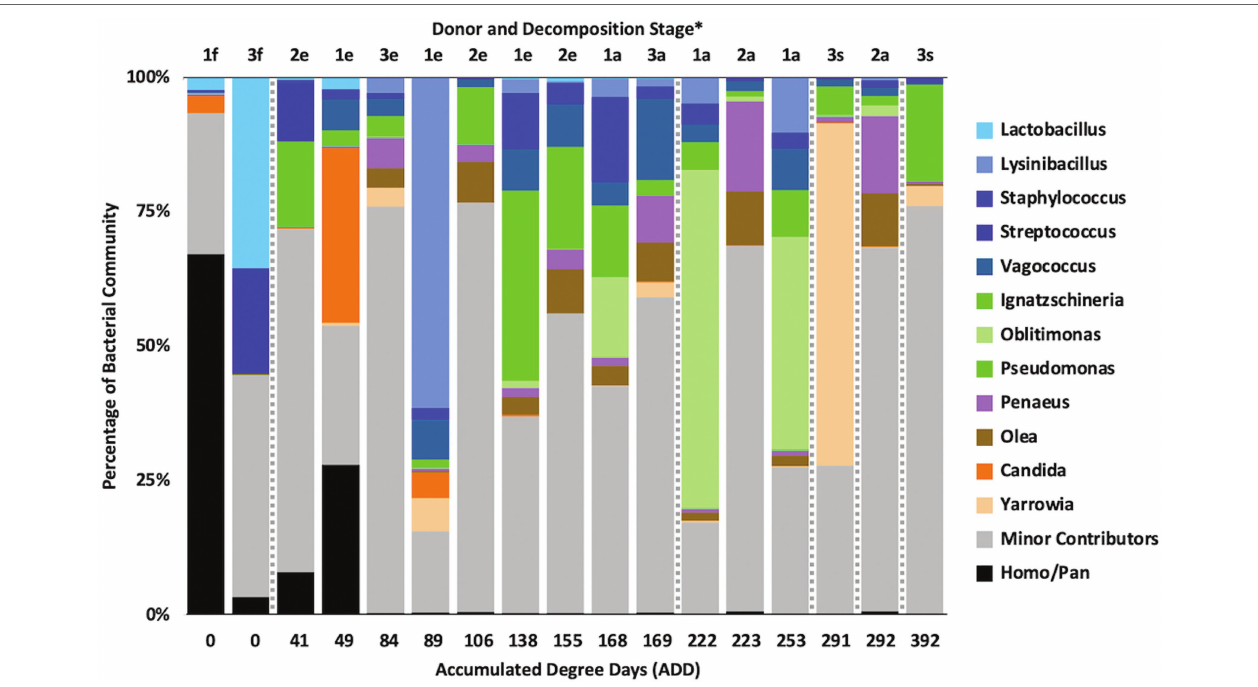
FIGURE 8 | Proportions of bacterial and eukaryotic genera determined from shotgun MetaG sequencing from oral samples of three human donors (Donors 1, 2, and 3) during decomposition. Decomposition was assessed as ADD on the x -axis and samples were also classified to an overall decomposition stage for each donor at each sampling event ( * f , fresh; e , early; a , advanced; and s , skeletonized). Minor contributors include data that accounted for <3% of the total diversity within a